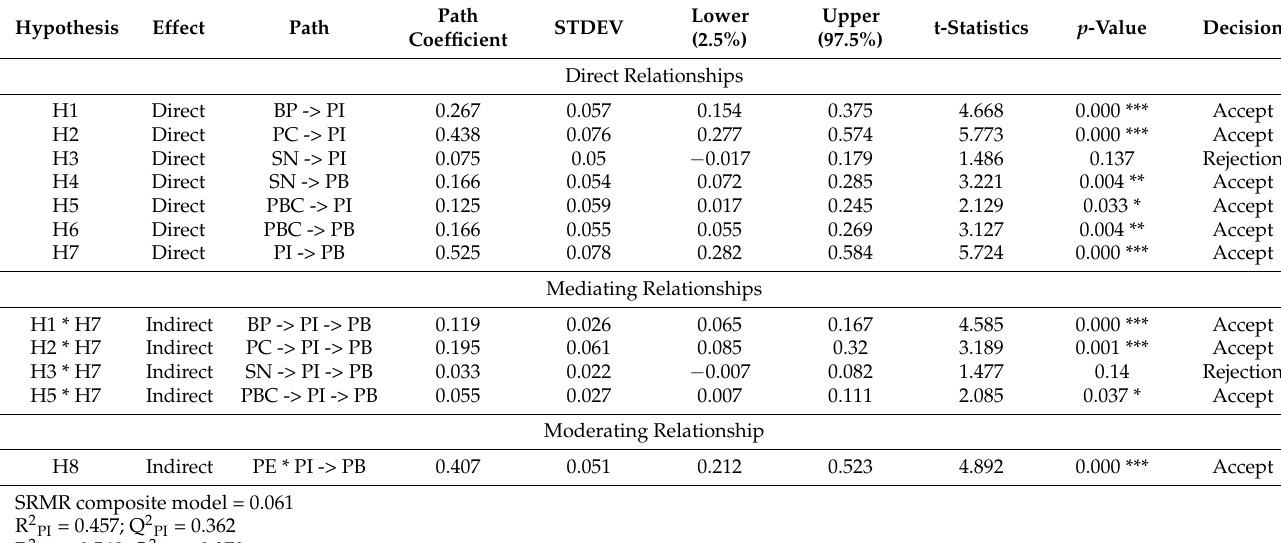
Table 5. Results of hypothesis